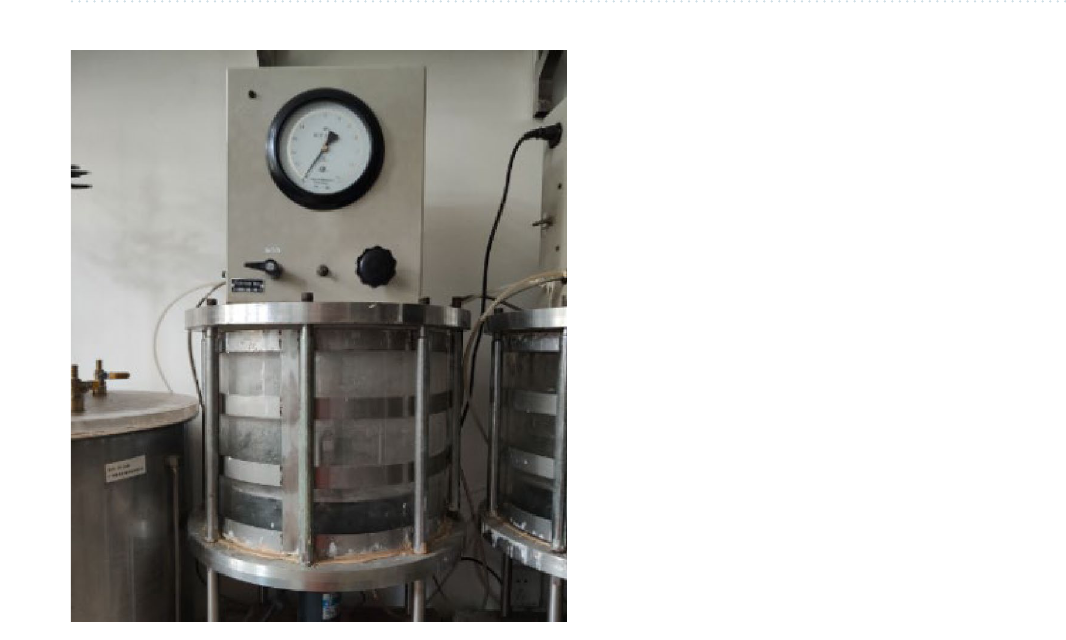
Figure 1. Prepared rock samples.